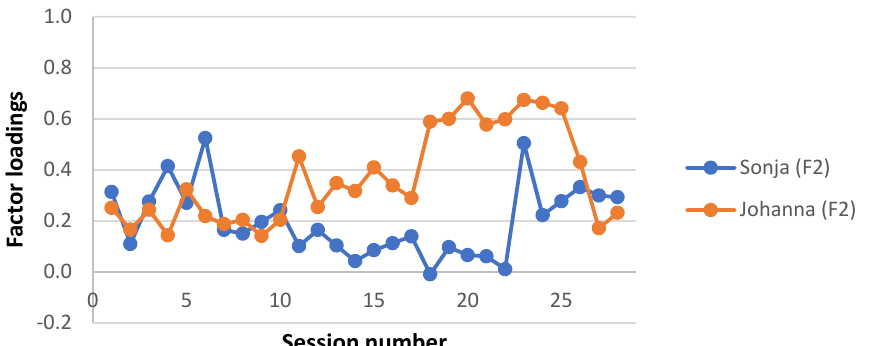
Figure 2. Interaction structure 2: “Working with anger and vulnerability”. Factor loadings on each session for Sonja and